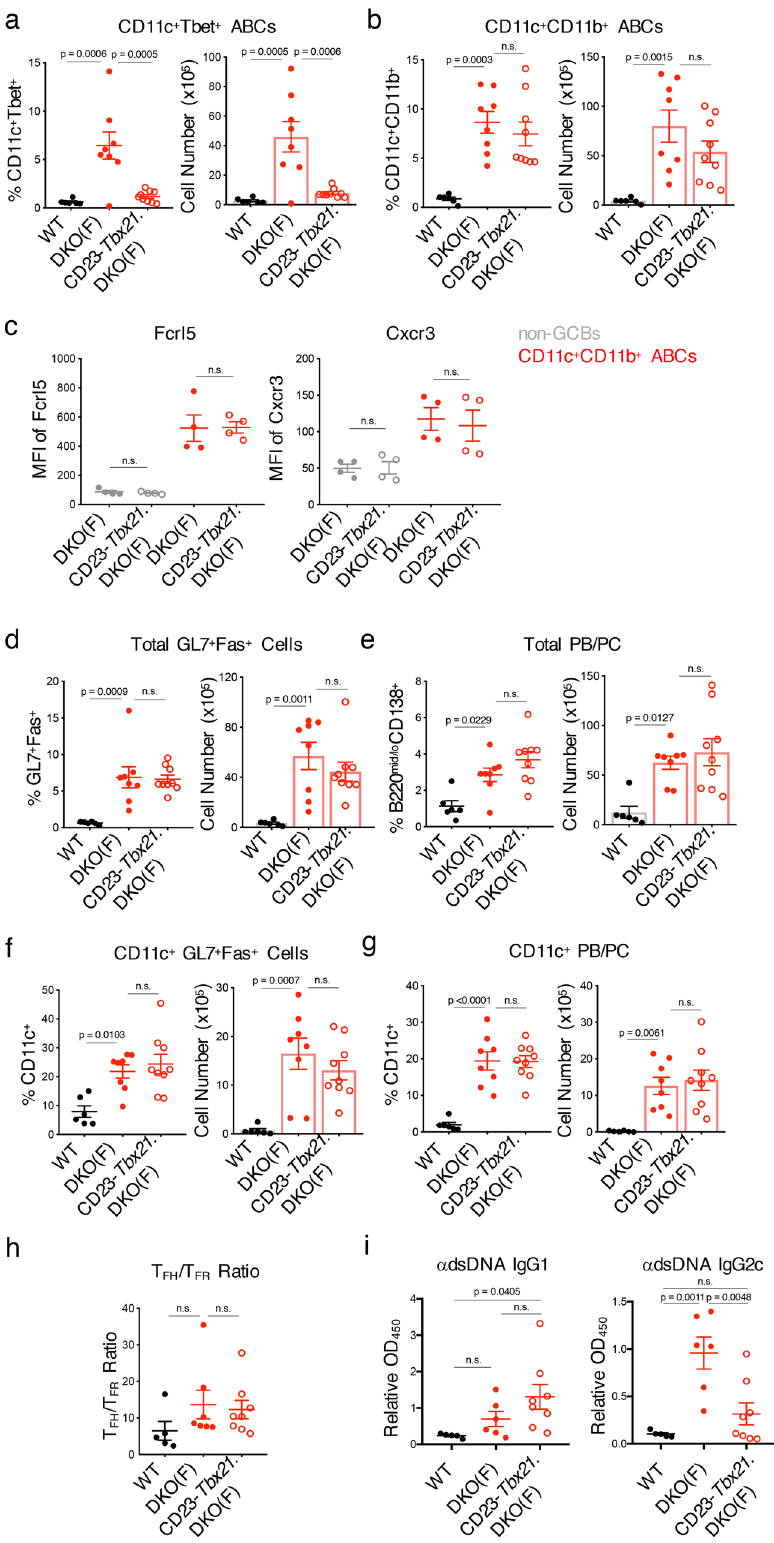
lung in fl ammation, but as compared to age-matched Yaa-DKO males, the fi ndings were less severe (Fig. 9d). Lung in fi ltrates in DKO females, however, worsened with age and were markedly ameliorated in aged CD23-Cre. Irf8 fl ox/ fl ox DKO females suggesting a crucial contribution of ABCs to the pulmonary in fl ammation (Fig. 9f). Thus, Tlr7 -driven expansion of ABCs and their